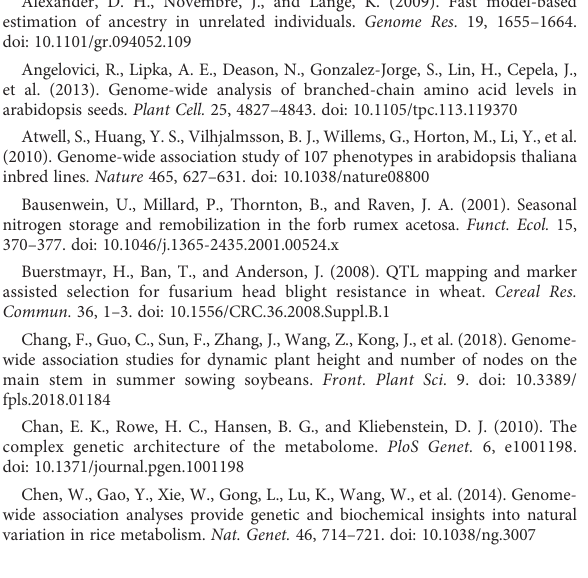
SUPPLEMENTARY FIGURE 1 Dot plots (lower triangle), histograms (diagonal) and Pearson correlations (upper triangle) between fi ve FAAs datasets. Best curves are fi tted in dot plots and histograms. *** indicates statistical signi fi cance at the 0.1% probability level, and the size of the coef fi cient value is proportional to the strength of the correlation. SUPPLEMENTARY FIGURE 2 Venn diagrams of unique QTNs detected by mrMLM series methods from Val (A) , Leu (B) , Ile (C) , Arg (D) and Trp (E) . SUPPLEMENTARY FIGURE 3 Common QTNs detected in different FAA datasets by different methods. (A) : QTN-0110944343; (B) : QTN-0123419417; (C) : QTN-0224189963; (D) : QTN-0224189963; (E) : QTN-0519754561; (F) : QTN-0916065720; (G) : QTN-1017905052. The size of the circle is proportional to the signi fi cance level. SUPPLEMENTARY FIGURE 4 GO classi fi cation of candidate genes harbored in stable QTLs in Val (A) , Leu (B) , Ile (C) , Arg (D) , Trp (E) datasets. SUPPLEMENTARY FIGURE 5 KEGG pathway analysis of candidate genes harbored in stable QTLs in Val (A) , Leu (B) , Ile (C) , Arg (D) and Trp (E) datasets. SUPPLEMENTARY FIGURE 6 Manhattan plots for fi ve FAA levels detected QEIs by 3VmrMLM. QEIs in Val (A) , QEIs in Leu (B) , QEIs in Ile (C) , QEIs in Arg (D) , QEIs in Trp (E) . Black horizontal lines in the Manhattan plots represent the genome-wide signi fi cant threshold. SUPPLEMENTARY FIGURE 7 GO classi fi cation of candidate genes harbored in QEIs in Val (A) , Leu (B) , Ile (C) , Arg (D) and Trp (E) datasets. SUPPLEMENTARY FIGURE 8 KEGGpathway analysisofcandidate genesharboredinQEIs inVal (A) , Leu (B) , Ile (C) , Arg (D) and Trp (E)